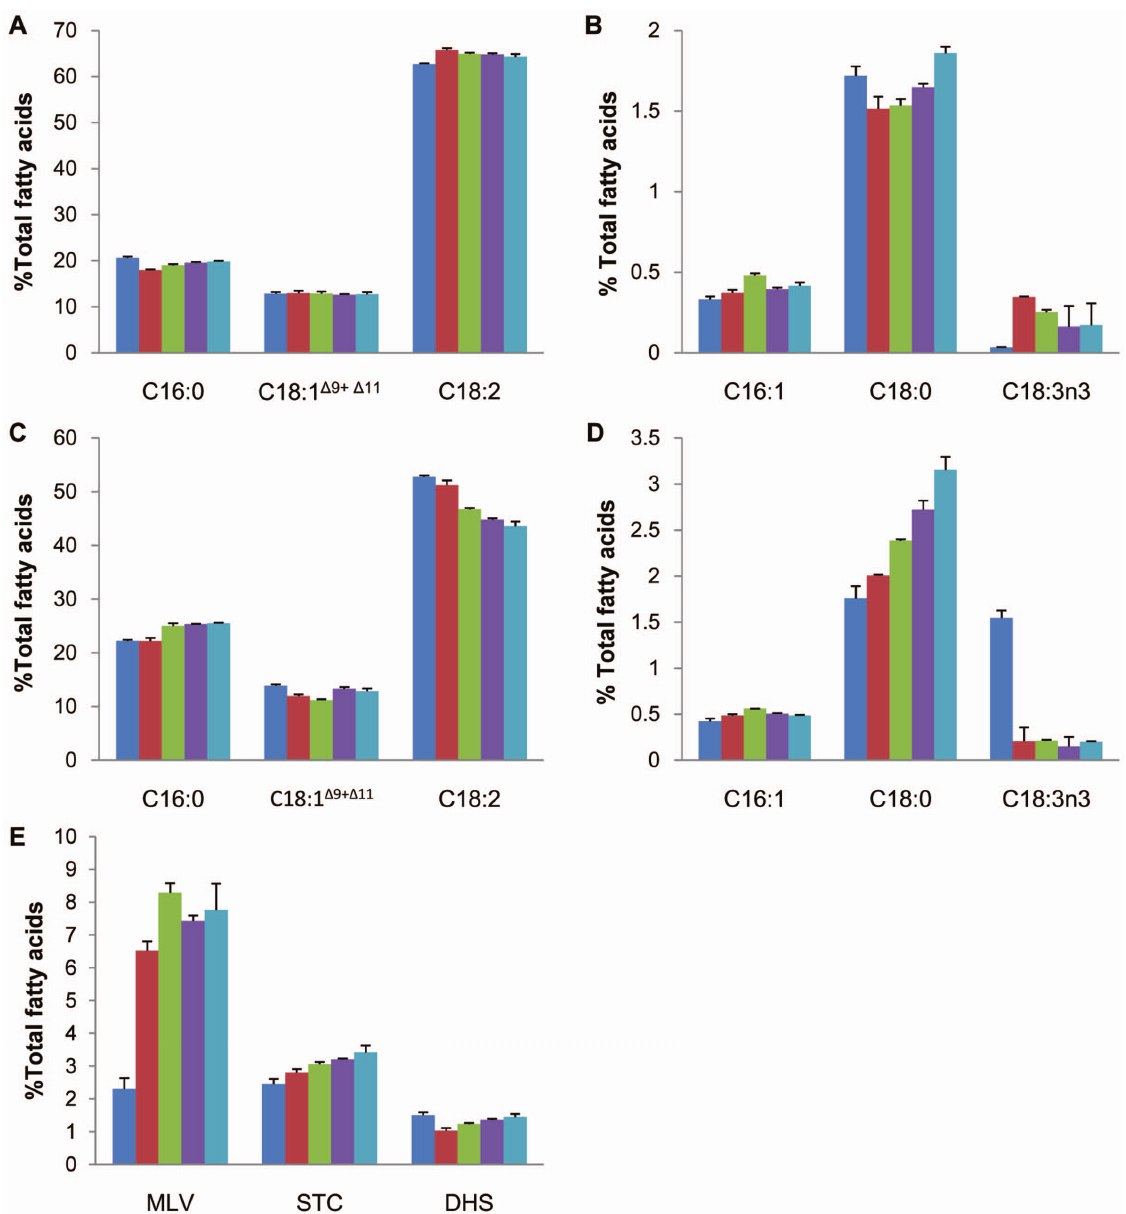
Figure 7. Fatty acid composition of total lipids from developing cotton embryo axis and cotyledon. A, major fatty acids in cotyledon; B, minor fatty acids in cotyledon; C, major fatty acids in embryo axis; D, minor fatty acids in embryo axis; E, carbocyclic fatty acids in embryo axis. Results represent the mean SD of three biological replicates. Minor fatty acid (accounting for , 1% of the fatty acid composition) are not shown. C16:0, palmitic acid; C16:1, palmitoleic acid; C18:0, stearic acid; C18:1 (mainly C18:1 D 9 , oleic acid, with a small amount of C18:1 D 11 , cis -vaccenic acid); C18:2, linoleic acid; C18:3 n3 , a -linolenic acid; MLV, malvalic acid; STC, sterculic acid; DHS, dihydrosterculic acid. Analysed samples were derived from developing cotton embryos of 25 DAP (blue), 30 DAP (red), 35 DAP (green), 40 DAP (purple), and 45 DAP (cyan). tion in embryo axis than cotyledon (Figure 8). Seven unigenes with low RPKM values in both the embryo axis and cotyledon libraries were identified as fatty acid elongases ( FAE ) and they all showed about 1 fold higher expression in cotyledon than in embryo axis (Table S5). This is also consistent with the exclusive presence of elongated fatty acids including C20:3 and C24:0 in cotyledons (Figure 8).